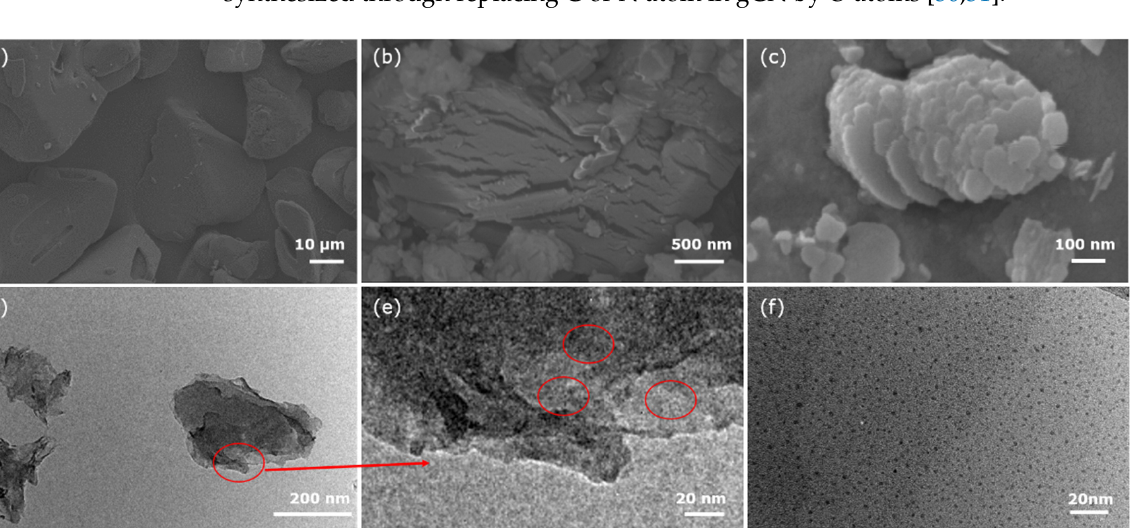
Figure 1. The SEM images of ( a ) melamine, ( b ) melamine precursor, ( c ) bulk O-gCN; the TEM im- ages of ( d ) O-gCN nanosheets, ( e ) the edge of O-gCN nanosheets at higher magnification, ( f ) OCNQDs.